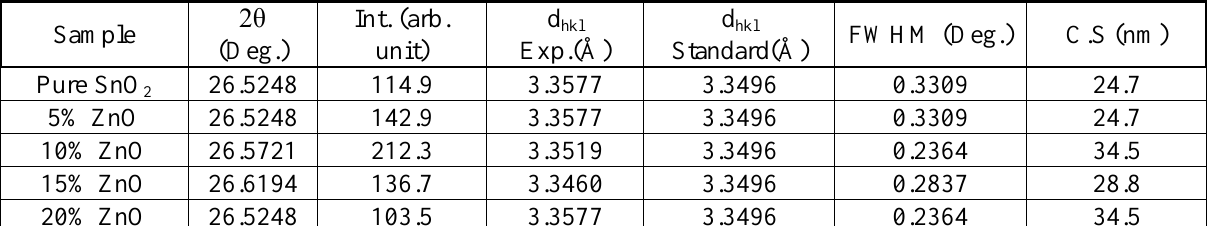
, FWHM and C.S for (110) peak hkl